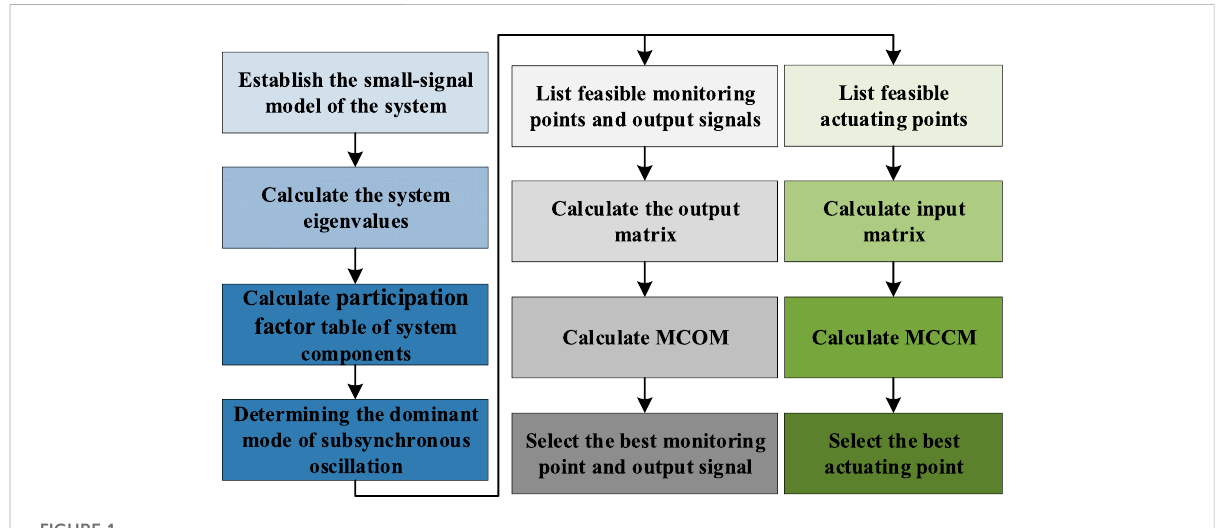
FIGURE 1 Application fl ow of MCOM and